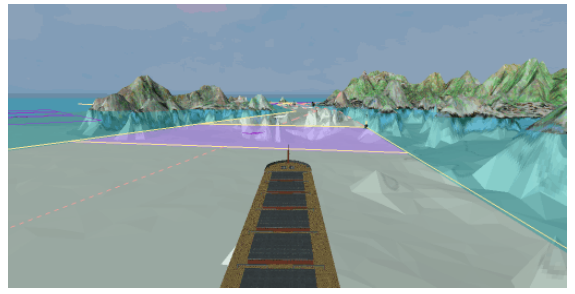
Figure 4. The onboard view of the model